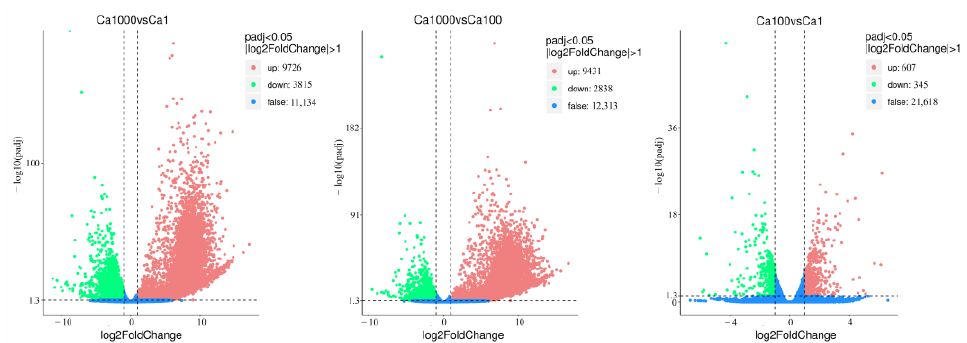
Figure 14. Differential gene volcano map for different concentrations of CaCl 2 groups.